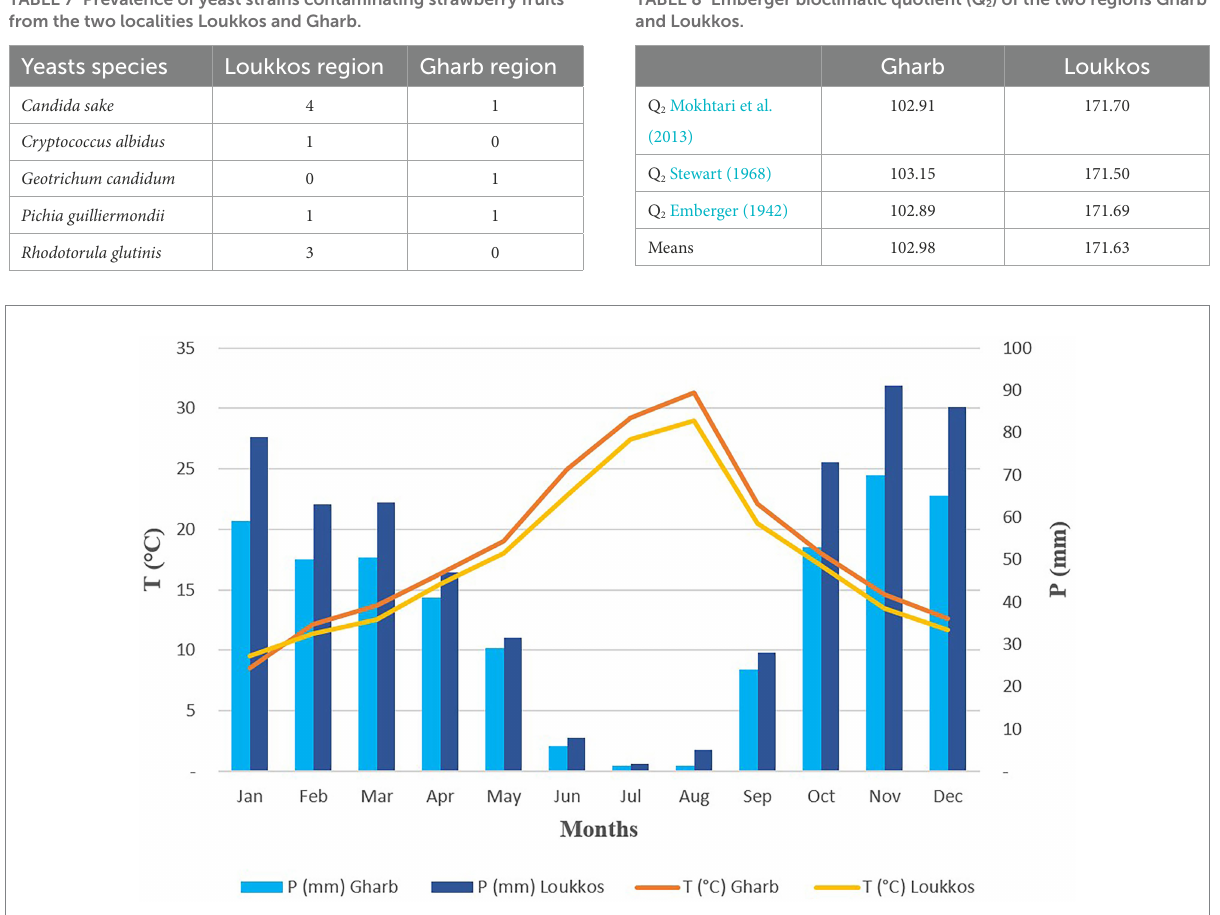
TABLE 8 Emberger bioclimatic quotient (Q 2 ) of the two regions Gharb and Loukkos. Gharb